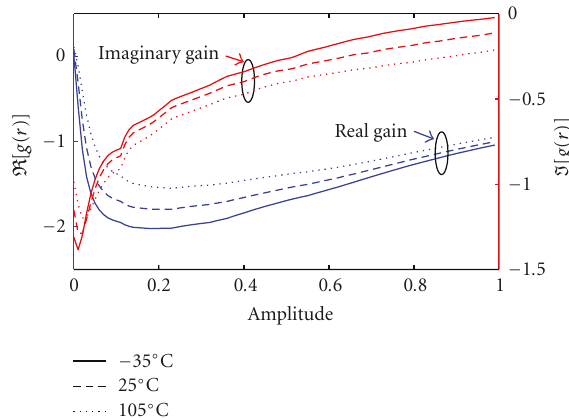
Figure 3: Real and imaginary parts of a class-E amplifier nonlinear- ity expressed as a complex-gain, over di ff erent temperature settings.